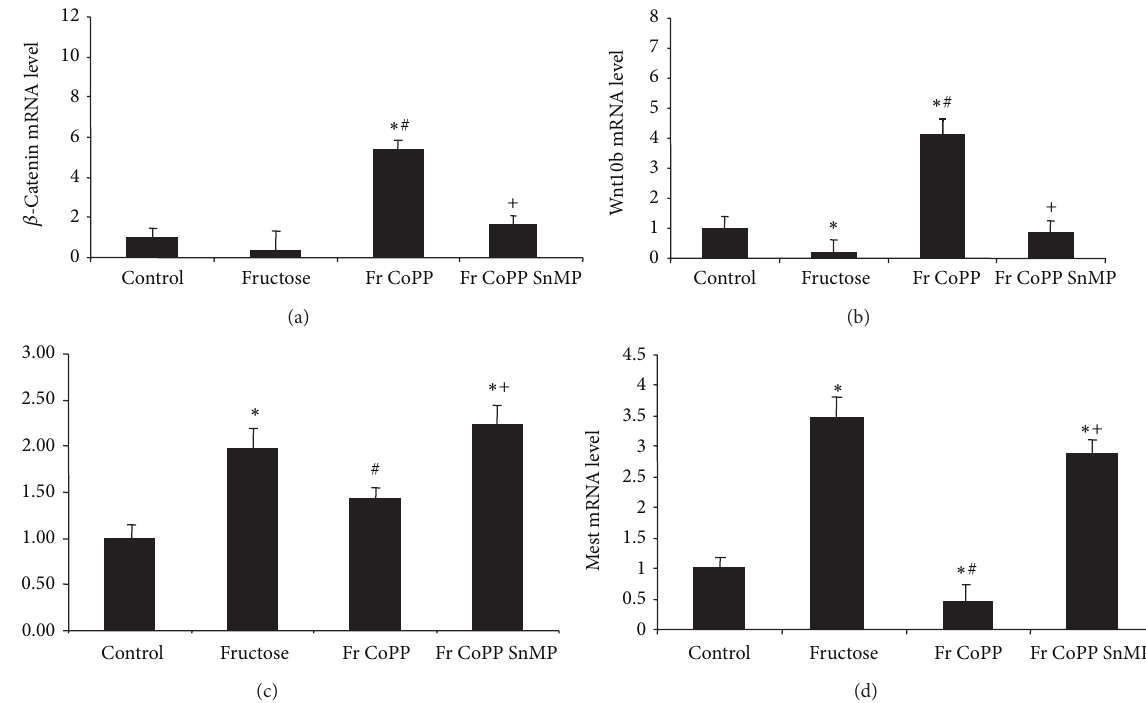
Figure 5: (a) Real-time PCR of 𝛽 -catenin; (b) Wnt10b; (c) aP2; and (d) Peg-1/Mest expression in MSCs separated into control, fructose, fructose treated with CoPP, and fructose treated with CoPP and SnMP. Values represent means ± SEM of five independent treatments. ∗ 𝑃 < 0.05 versus control or # 𝑃 < 0.05 versus fructose or + 𝑃 < 0.05 versus fructose with CoPP.